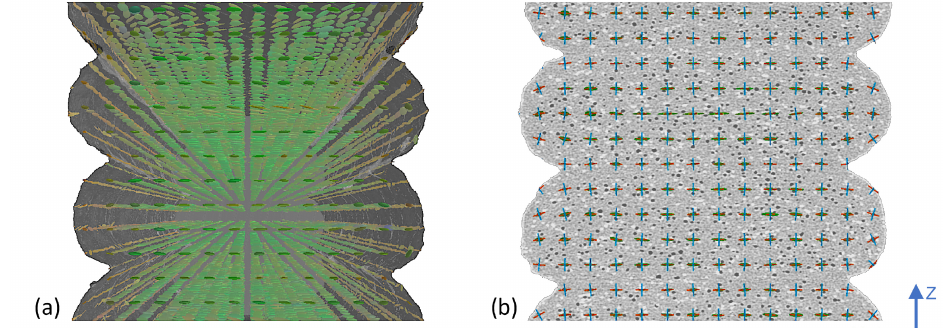
Figure 9. Front view of the fiber orientation tensors of a single-strand specimen at a substrate temper- ature of 200 °C and a layer height of 1.0 mm in ( a ) a 3D representation and ( b ) a 2D sectional image.